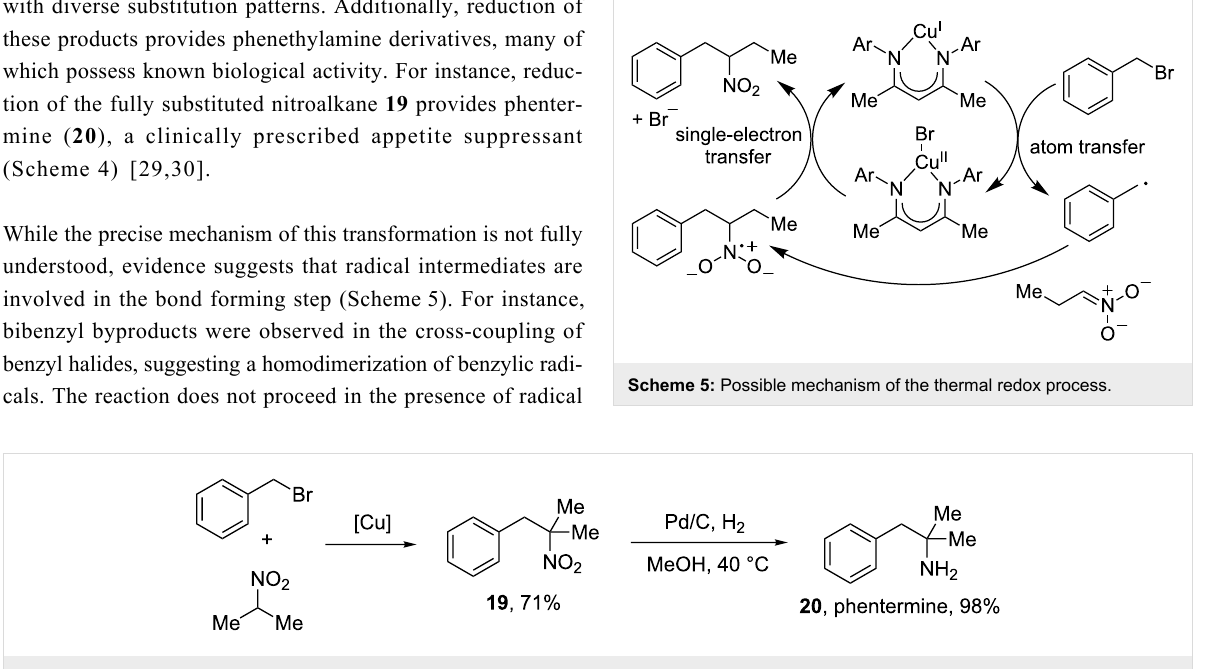
Scheme 4: Application of the nitro-alkylation reaction to the synthesis of phentermine.